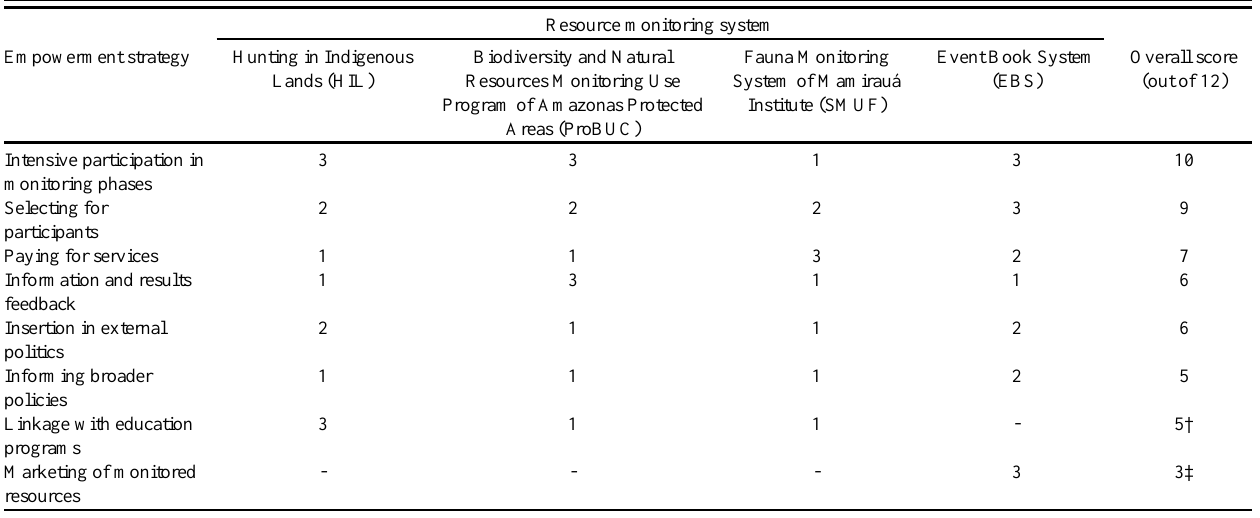
Table 2. Strategies used to promote local empowerment. Numbers represent the authors’ evaluation of the strategy’s level of importance for local empowerment using a four-point scale, with 3 the highest and 0 the lowest degree of importance. A dash indicates that the strategy was not employed in the